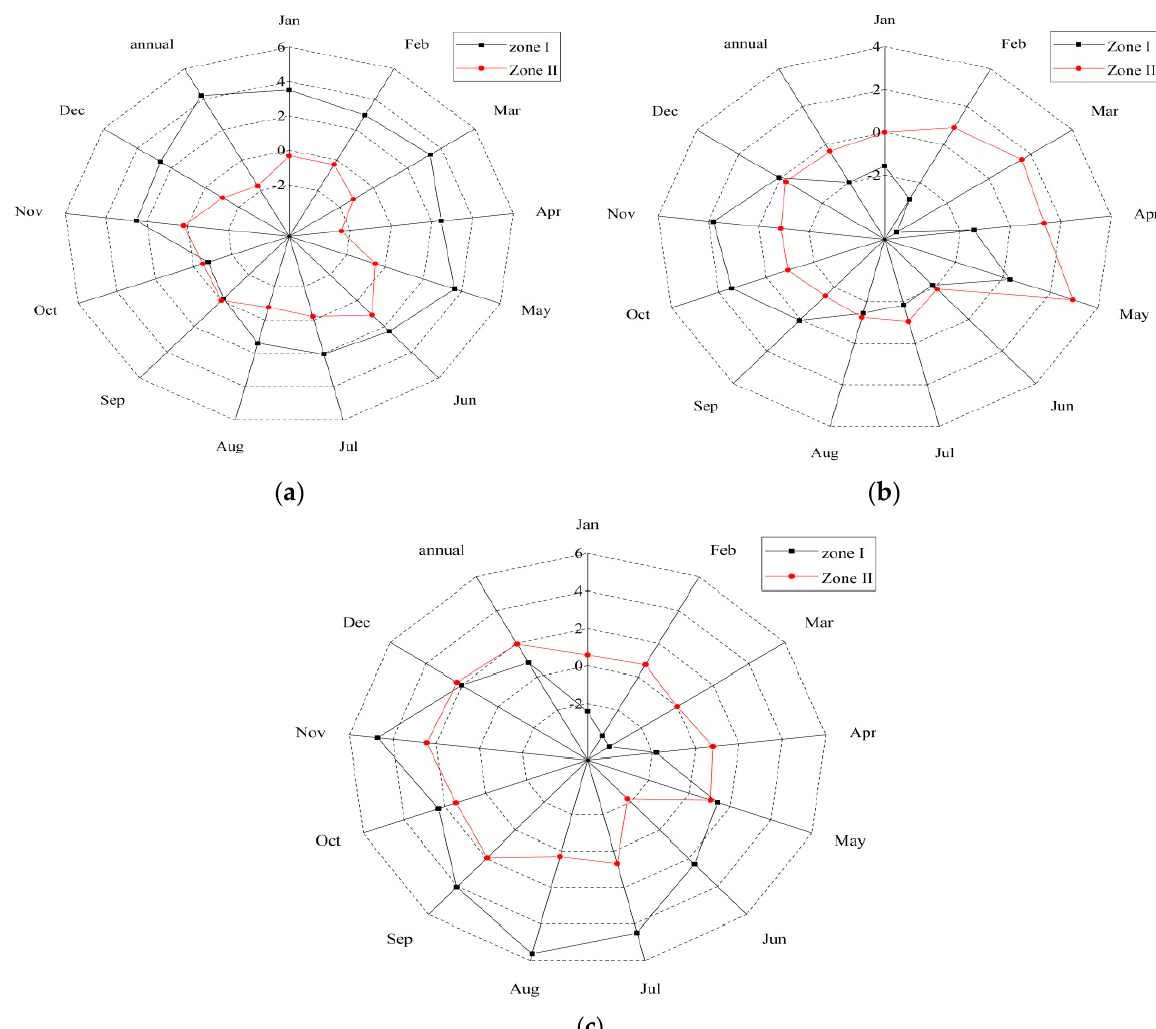
Figure 7. Comparison of Mann–Kendall (MK) trends of ( a ) precipitation, ( b ) runoff and ( c ) temperature of Zones I and